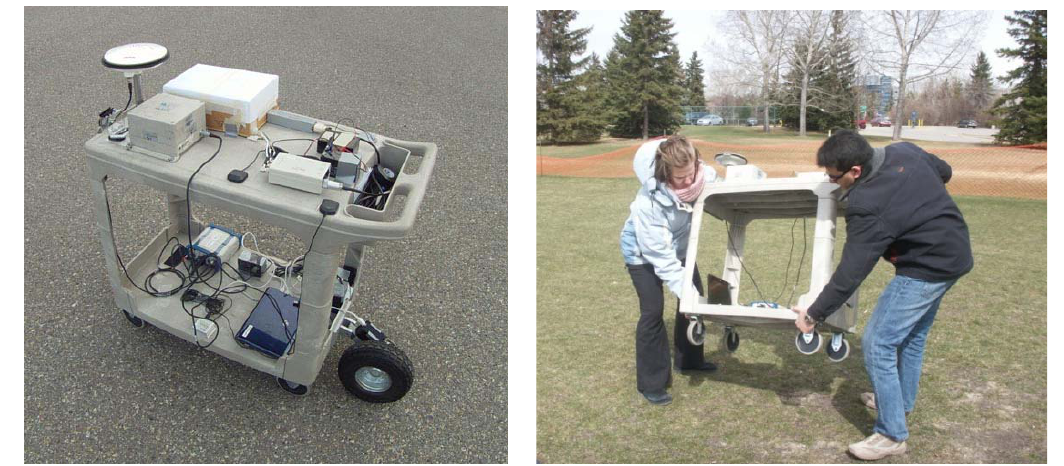
Figure 3. Test setup for the magnetic field survey including the Bartington fluxgate and the SPAN CPT HG1700 INS System from NovAtel.